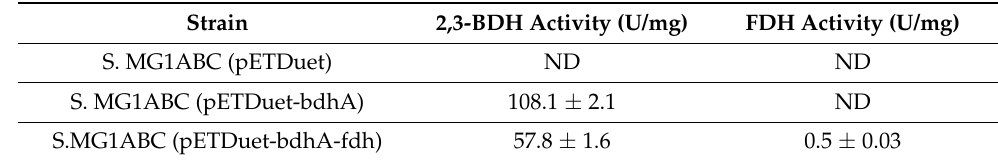
Table 1. Activities of 2,3-BDH and FDH.